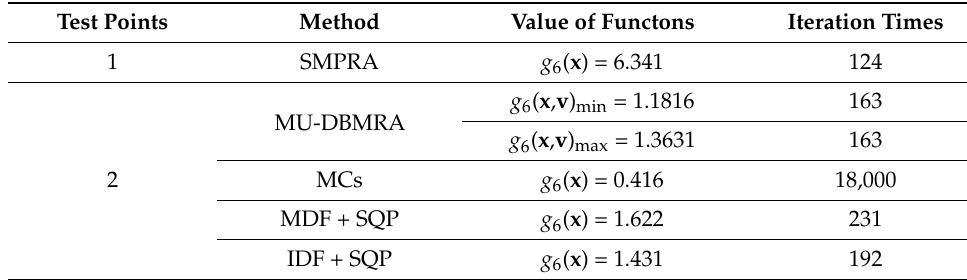
Table 4. The reliability analysis results of g 6 .